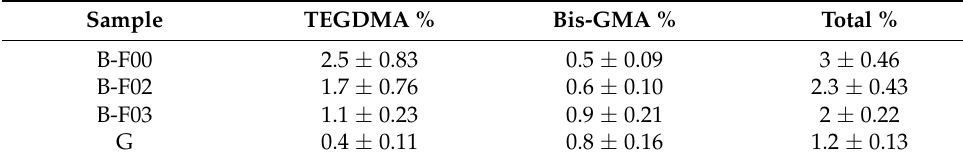
Table 2. The residual monomer (% ± SD) related to the weight of the sample.